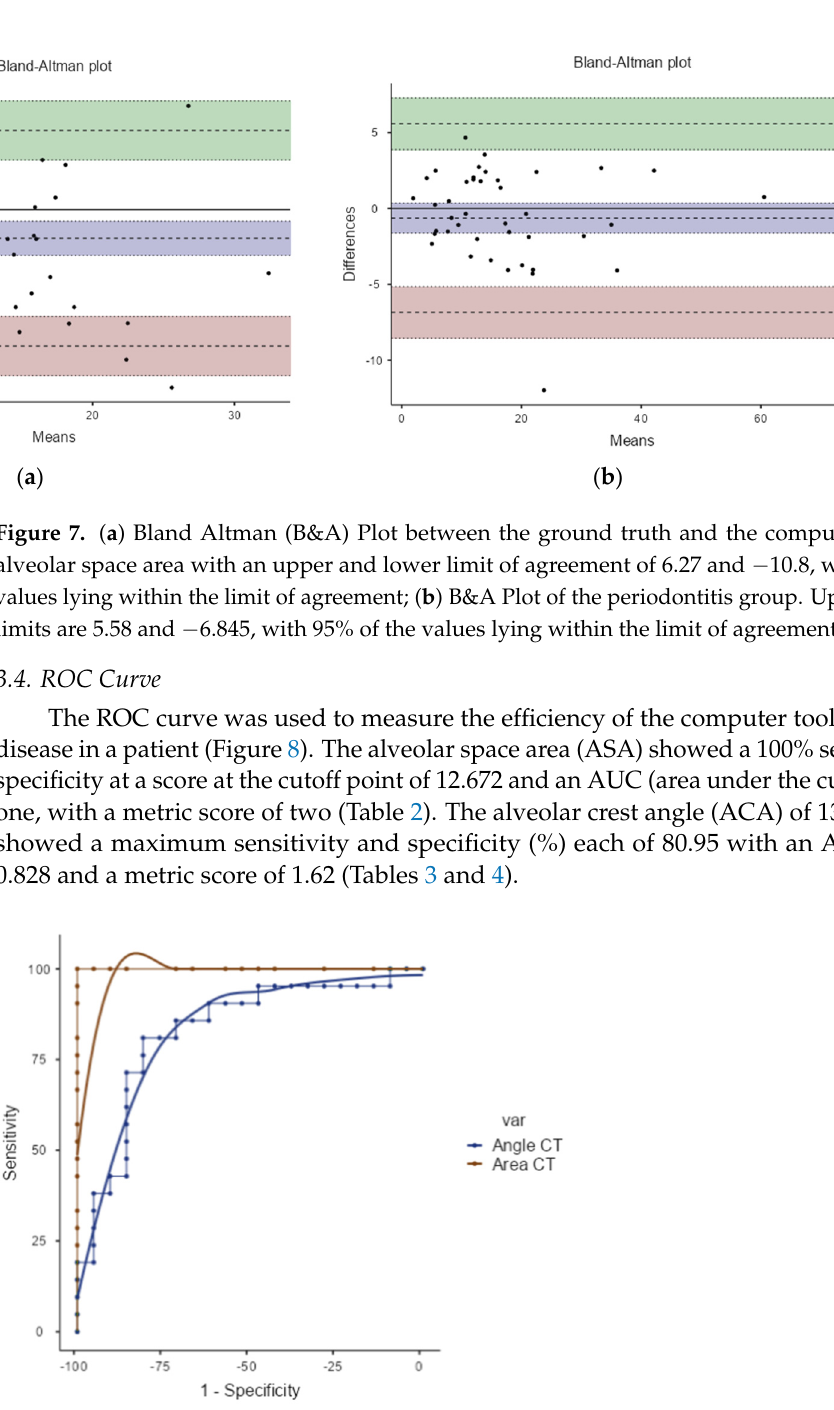
Table 3. The Sensitivity and Specificity cutoff values of the Alveolar crest Angle (ACA) as estimated by the Computer Tool (CT).